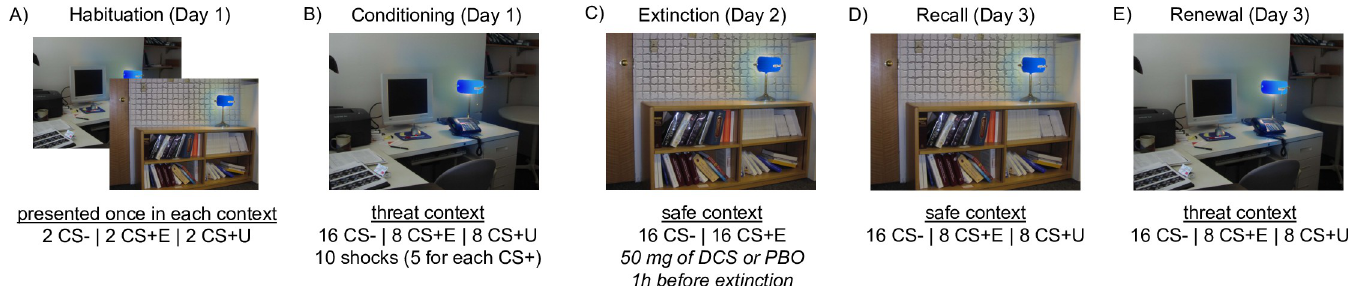
Fig 1. Schematic of experimental paradigm. In the habituation phase on Day 1, stimuli (i.e., lamp “turning on” to show one of three colors) were presented across the two contexts (A). In the conditioning phase on Day 1 (B), the color of the lamp light served as a conditioned Stimulus. Three lights were presented randomized and counterbalanced across participants. Two lights were paired with shock at a 62.5% reinforcement rate and served as the conditioned stimuli that either underwent extinction on Day 2 (CS+E) or remained unextinguished until Day 3 (CS+U). A third color, never paired with shock, provided a reference for differential conditioning (CS-). In the extinction phase on Day 2 (C), the CS+E and CS- were presented without shock in a different (safe) context. One hour prior to extinction, participants took either DCS or PBO. In the recall (D) and renewal (E) phases on Day 3, all three stimuli were presented without shock to test between-session extinction retention and generalization of extinction to the threat context,